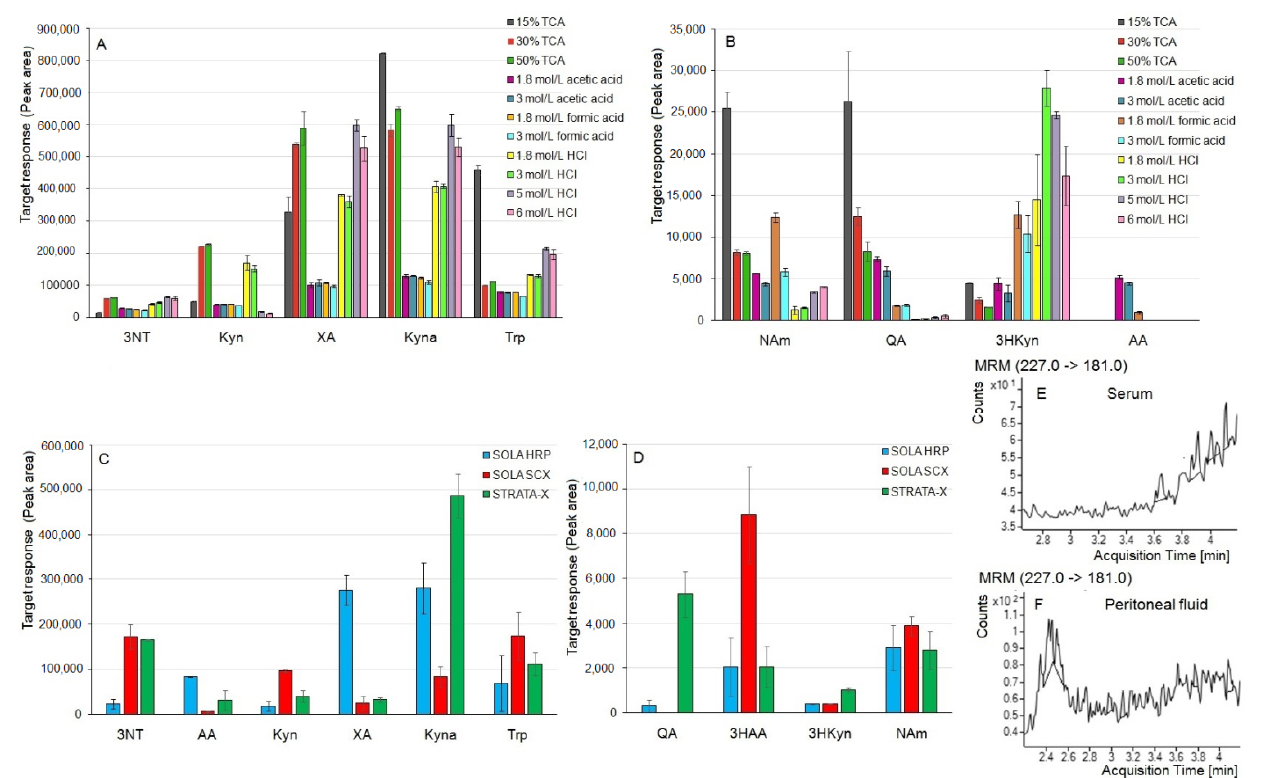
Figure 3. Results for optimization of the serum ( A , B ) and peritoneal fluid preparation ( C , D ) for UHPLC-ESI-MS/MS anal- ysis. ( A , B ) Effect of different solvents used for protein precipitation from the serum on the MS response of the target compounds. Serum (100 µL) fortified with analytes (0.5 mg/L each) was mixed with 50 µL of the precipitating solvent, which was centrifuged (14,000× g , 15 min, 4 °C), and the supernatant was transferred into a chromatographic vial and